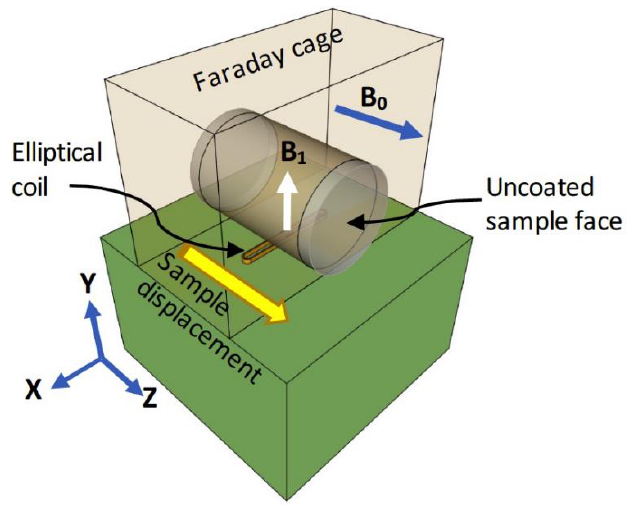
Figure 2. Three-magnet array [8] with the elliptical surface RF coil to excite a thin region of the sample perpendicular to the sample displacement. Reprinted with permission from ref. [11].